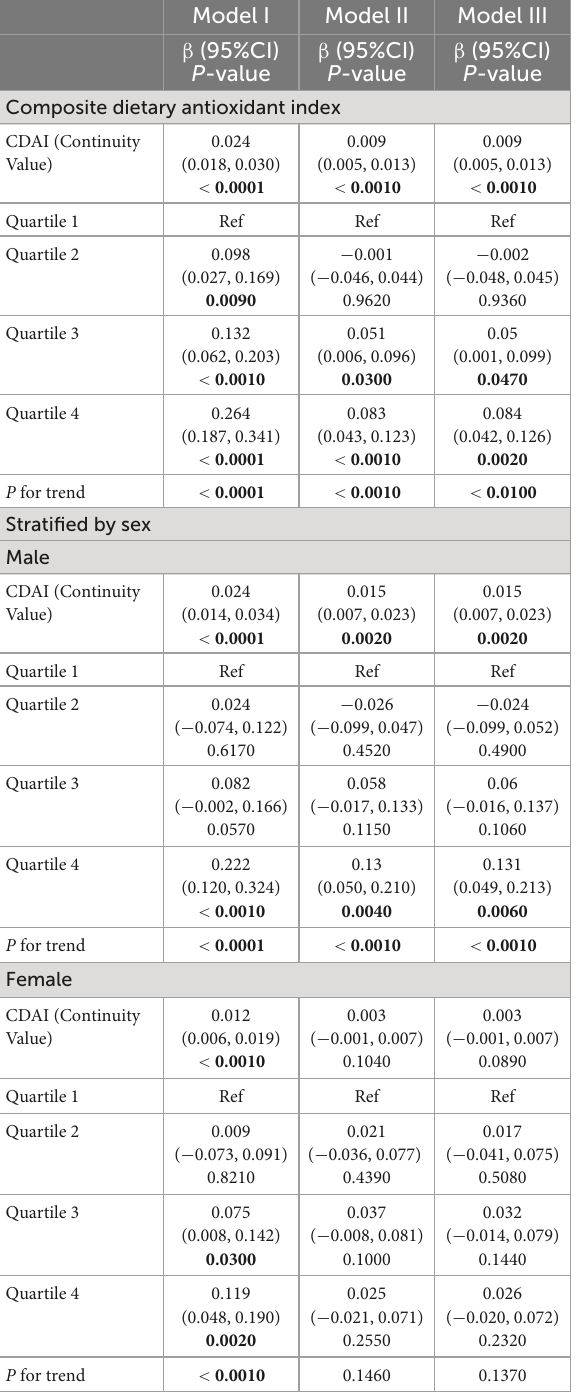
TABLE 2 The association between composite dietary antioxidant index and handgrip strength. Model I Model II Model